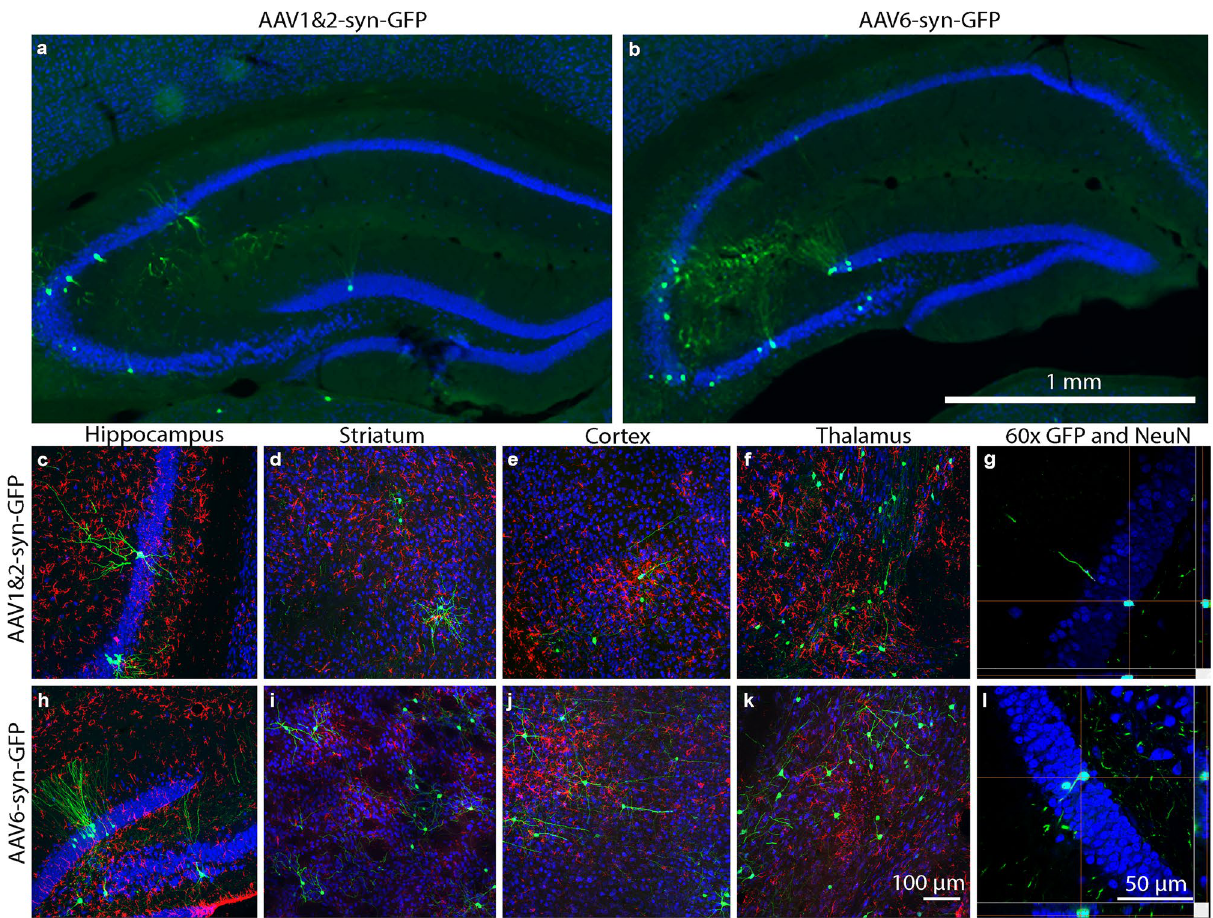
Figure 3. Transgene expression in neurons after MRIgFUS delivery of AAV to the hippocampus, striatum, thalamus, and cortex. AAV1&2-synapsin-green fluorescent protein (AAV1&2-syn-GFP) ( a , c–g ) and AAV6- syn-GFP ( b , h–l ) were delivered from the blood to the brain, unilaterally, via MRIgFUS permeabilization of the bood-brain barrier. A 20 × compiled virtual slice of the hippocampus shows GFP-positive neurons (GFP, green; NeuN, blue) after delivery of AAV1&2 and AAV6 ( a , b ). AAV1&2 and AAV6 resulted in GFP expression (GFP, green; NeuN, blue; GFAP, red) in the hippocampus ( c , h ), striatum ( d , i ), cortex ( e , j ), and thalamus ( f , k ). At 60 × magnification ( g and l ), colocalization between neuronal cell type (NeuN, blue) and transgene expression (GFP, green) is shown in